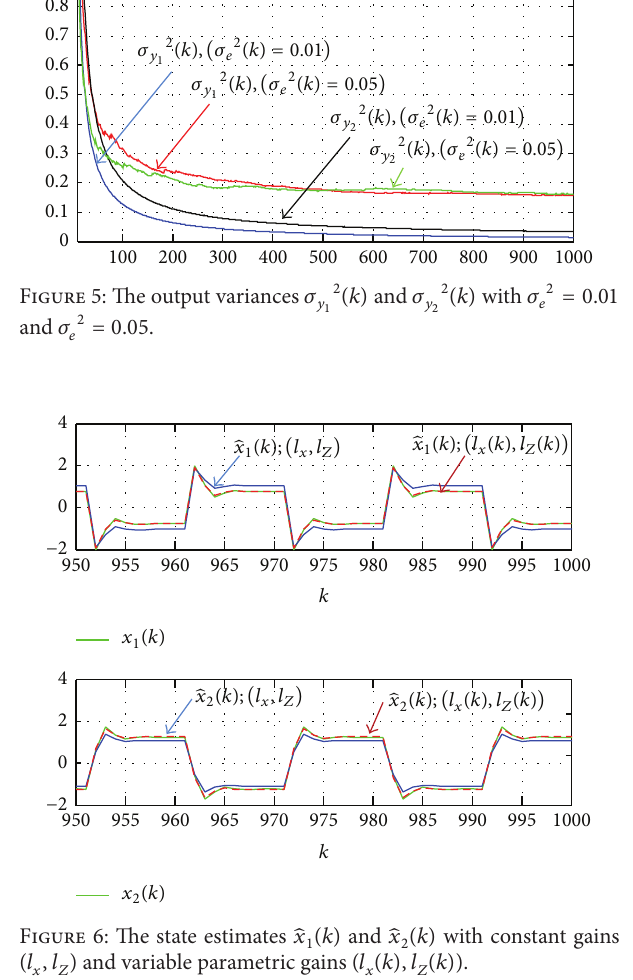
Figure 6: The state estimates ̂𝑥 1 (𝑘) and ̂𝑥 2 (𝑘) with constant gains ( 𝑙 𝑥 , 𝑙 𝑍 ) and variable parametric gains ( 𝑙 𝑥 (𝑘) , 𝑙 𝑍 (𝑘) ).